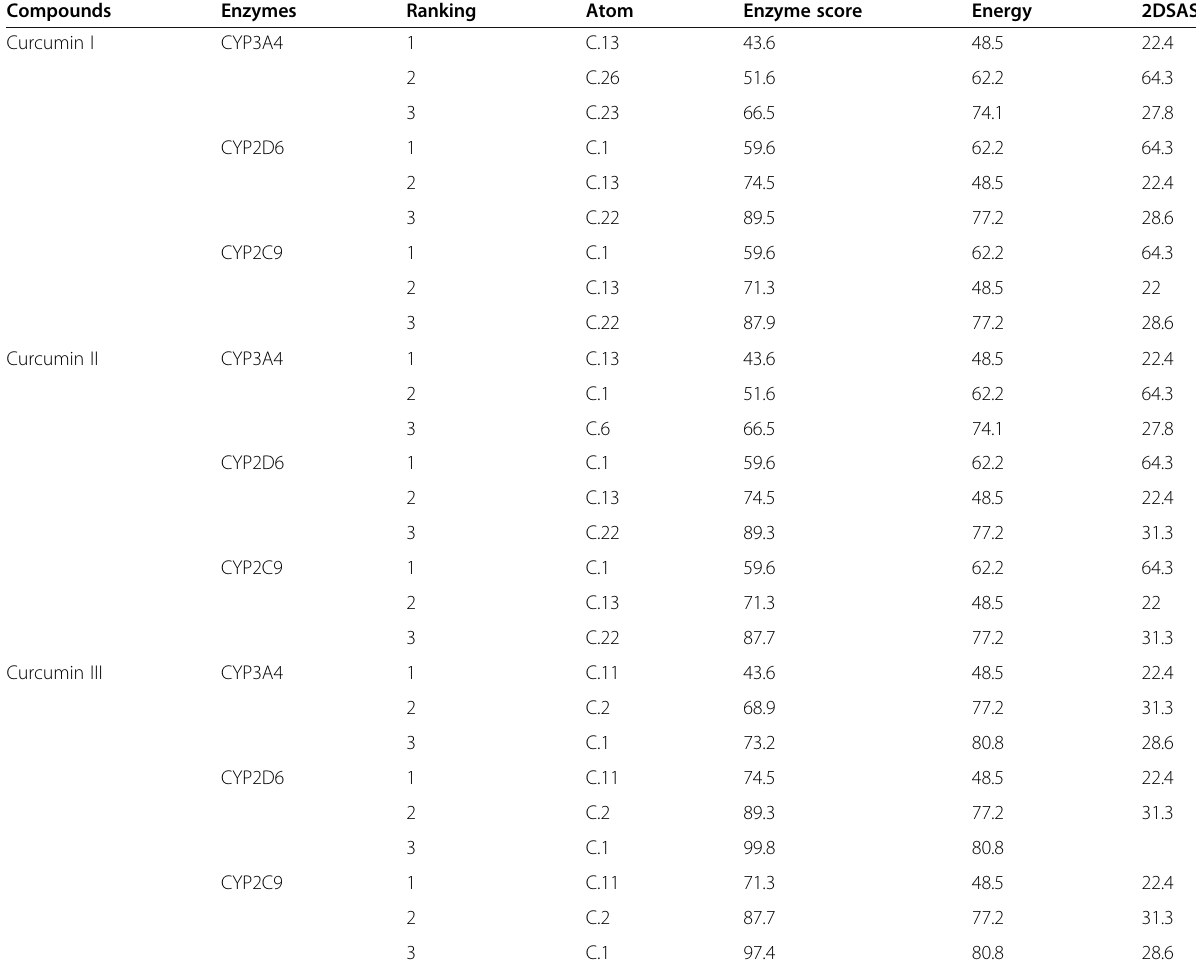
Table 5 Result of P450 metabolism site prediction. Atoms are ranked on the basis of lowest enzyme score which means the highest probability of being catalyzed by enzyme. Enzyme Score: Energy - 8*A - 0.04*SASA. A: Accessibility (not shown) is the relative distance of an atom from the center of molecule. Energy: approximate activation energy required for CYP active site to catalyze particular atom. SASA: solvent accessible surface area means local accessibility of atom. 2DSASA: value calculated from molecular topology